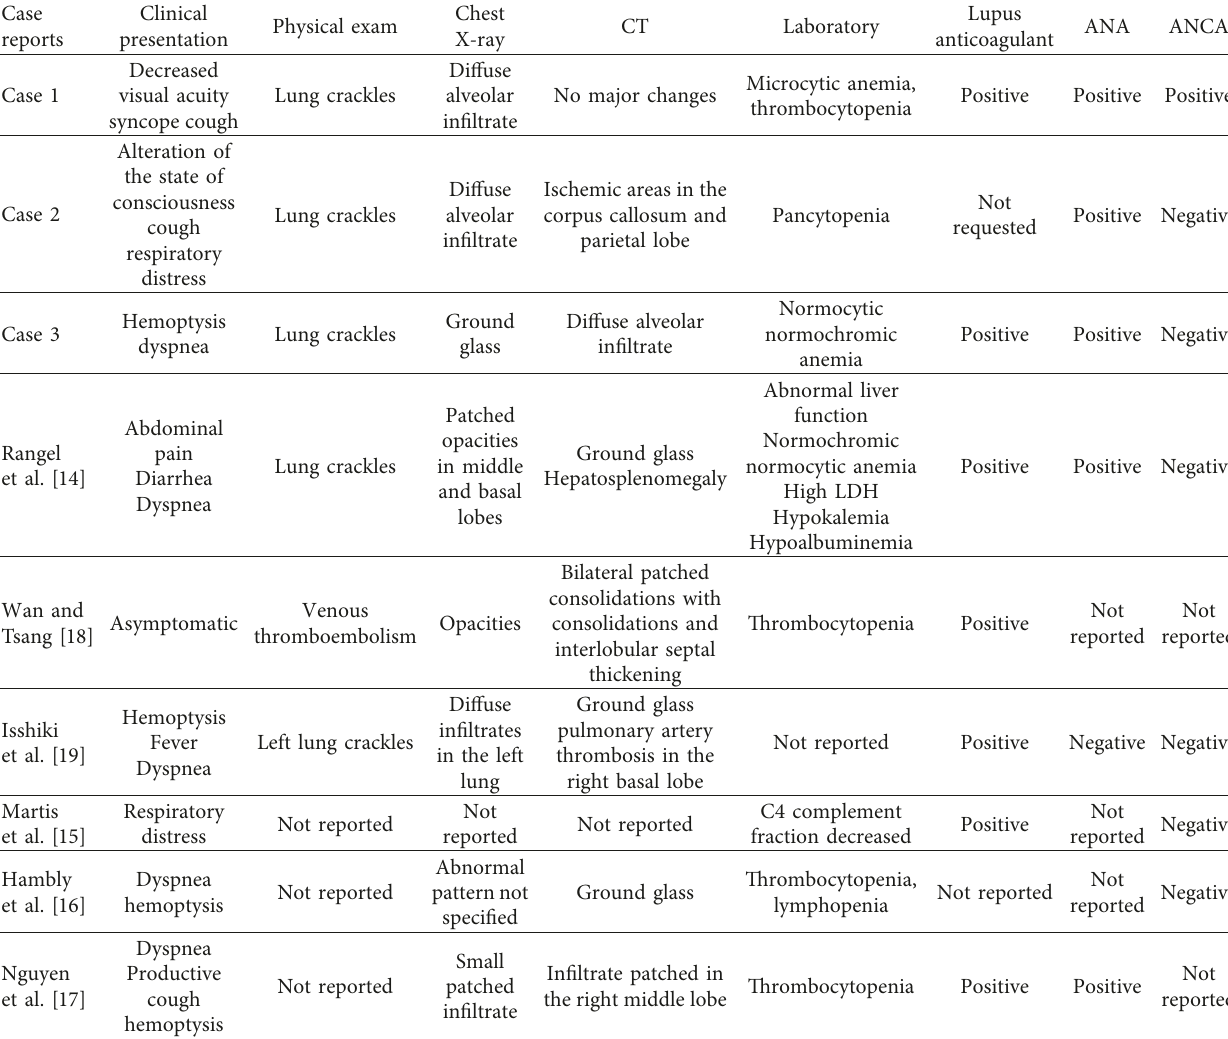
Table 3: Comparison of characteristics of patients with alveolar hemorrhage.